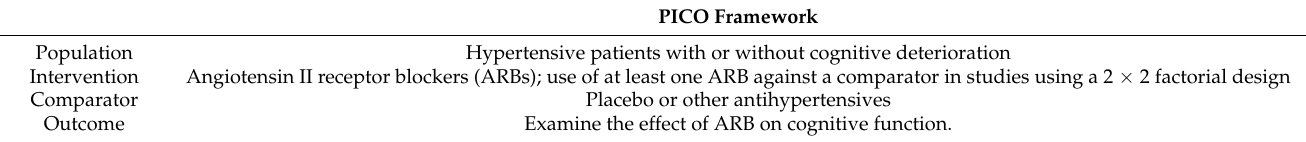
Table 3. The PICO framework used to construct the search strategy which details the population, the intervention, the comparator, and the outcome used to ensure that the inclusion criteria follow a specific guideline.